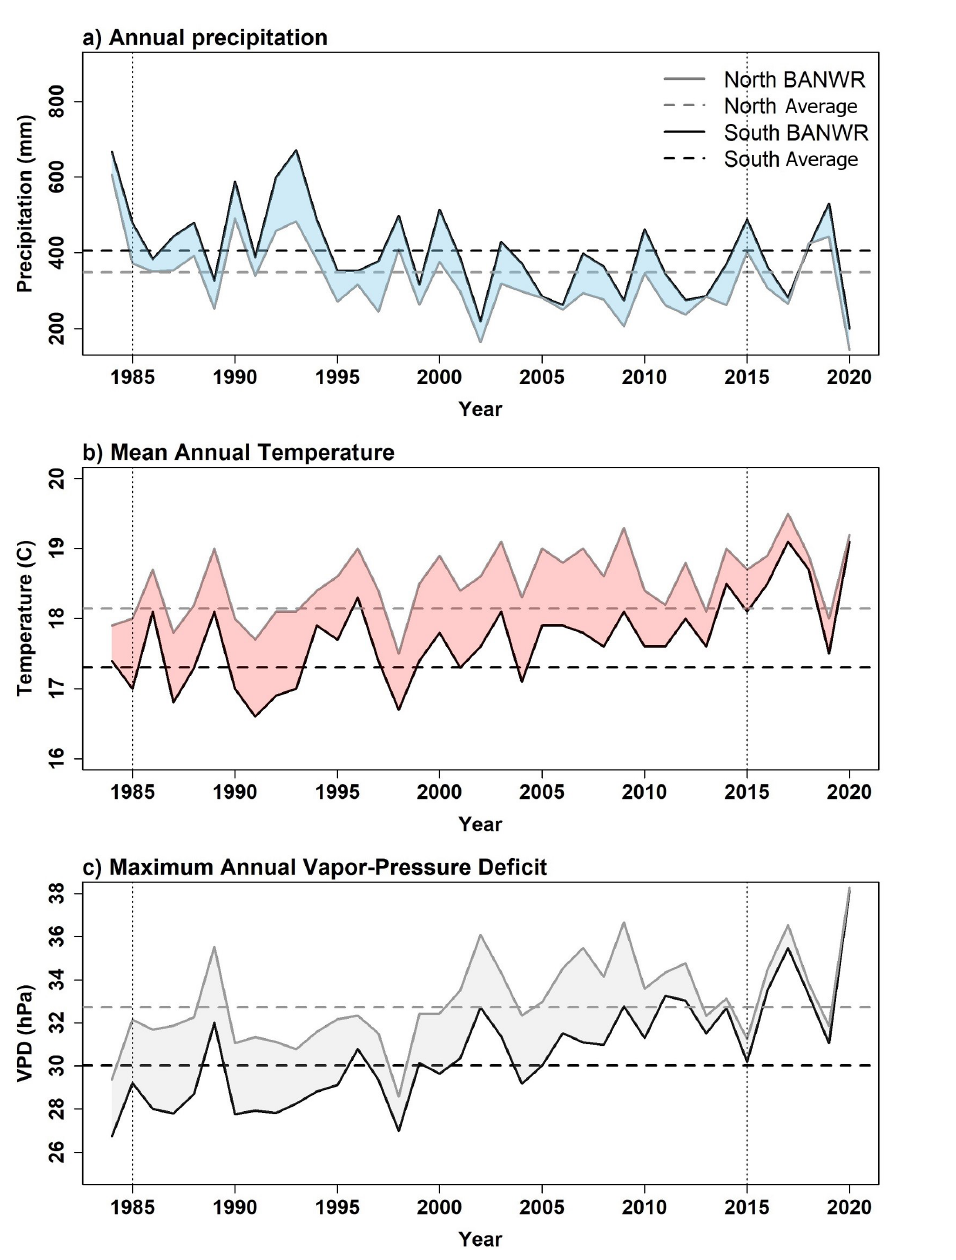
Figure 2. Climate variables from Parameter-Elevation Regressions on Independent Slopes Model (PRISM) data showing ( a ) annual precipitation, ( b ) mean annual temperature, ( c ) and maximum annual vapor-pressure deficit in the northern (gray solid lines) and southern (black solid lines) parts of BANWR since the establishment of the refuge (1985) and launch of Sentinel-2A (2015), indicated with vertical dashed lines. Long-term (1985–2014) historical averages of climate variables are shown by horizontal dashed